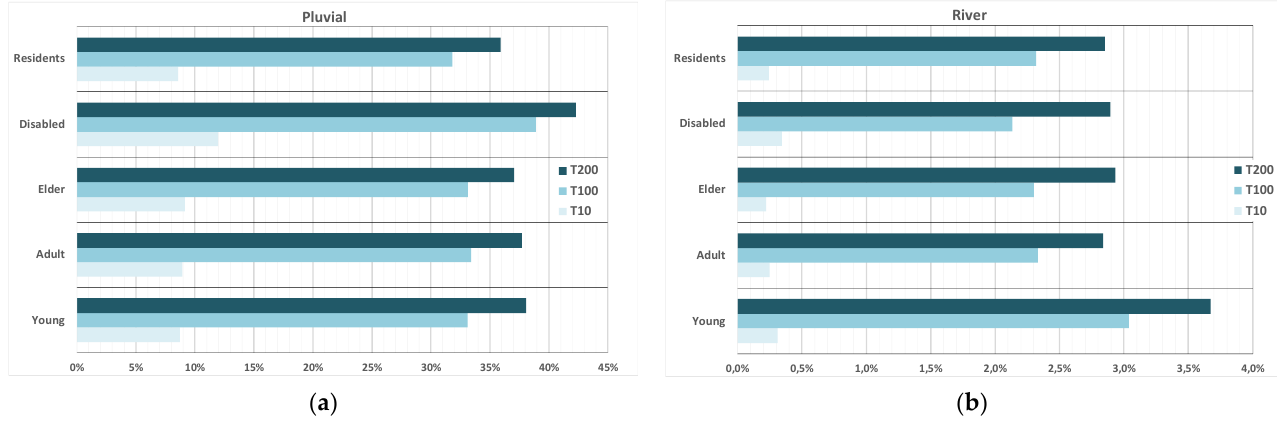
( b ) Figure 7. Economic service accessibility impact: ( a ) pluvial flood; ( b ) river flood. Finally, Figure 8 shows the number of services lost at the different probabilities of occurrence of the events to represent the traditional risk curve. The results show that for both hazards, the loss of economic services is higher compared to the loss of social ser- vices.